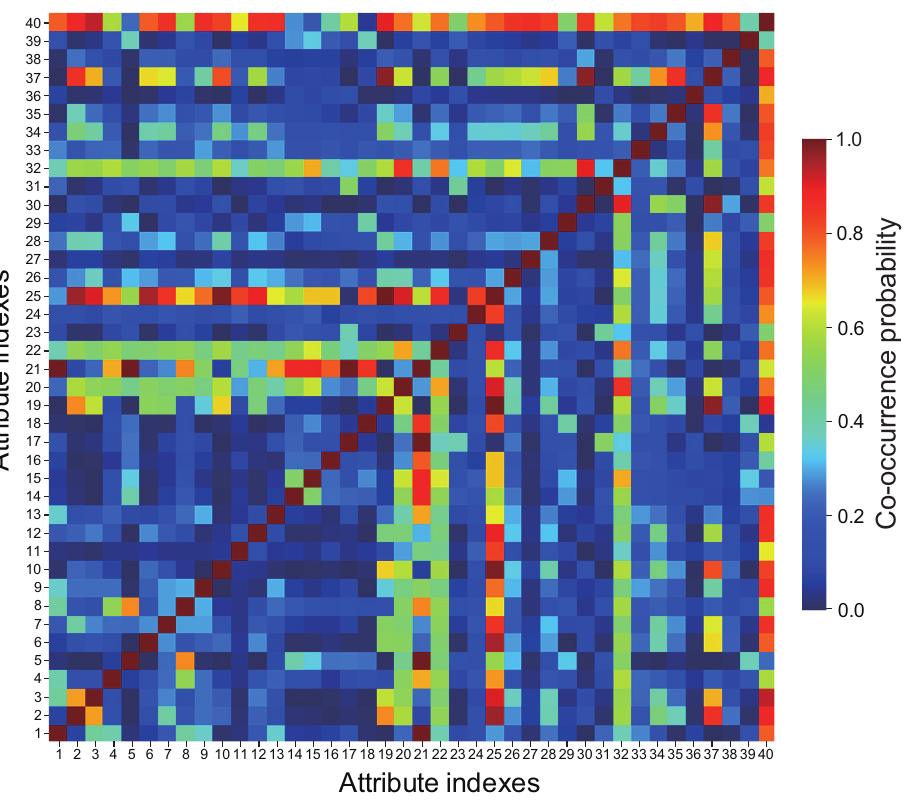
Figure 3. Color map visualizing the co-occurrence probabilities of 40 face attributes in